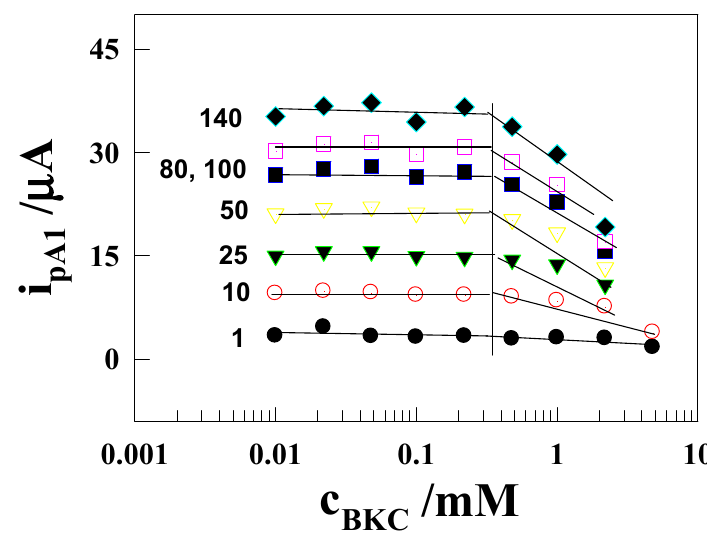
Figure 2. Anodic peak (A1) current as a function of BKC concentration for the oxidation of 1 mM [Co(II)(bpy) 3 ] 2+ on a GCE in 0.1 M Na 2 SO 4 solution at various scan rates.